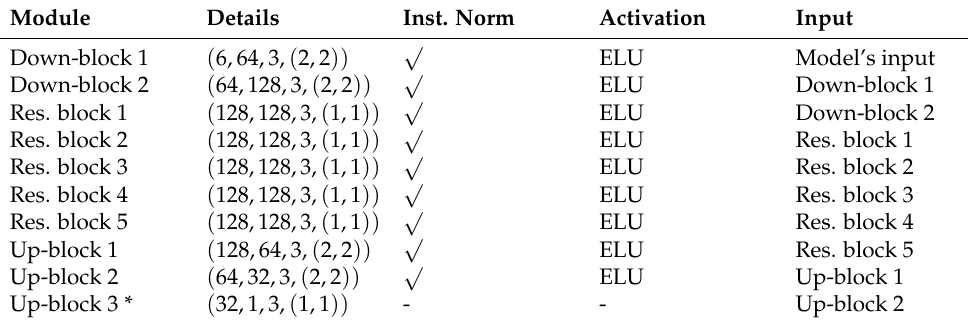
Table A2. Refinement model specifications. Module names with an asterisk (*) are model outputs. For down-blocks, up-blocks and residual blocks (Res. blocks), the numbers in the Details column represent input channels, output channels, kernel size, and stride of the convolution window or up-sampling factor,